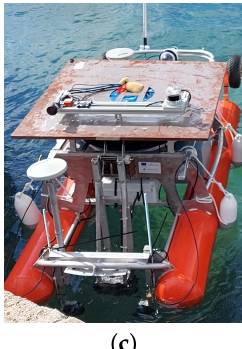
Figure 9. ( a ) Testing of the ASV Korkyra at LABUST’s pool. ( b ) Maiden voyage and testing of ASV and ROV controls system integration at sea in Split, Croatia in April 2021. ( c ) Ouster OS1-128 lidar and FLIR Blackfly S USB camera integration testing at sea in Biograd na Moru, Croatia in October 2021.